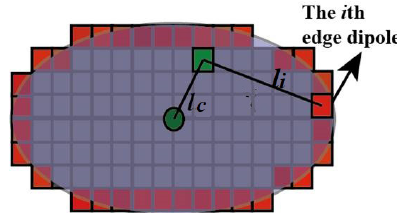
Figure 1. The generation of irregular